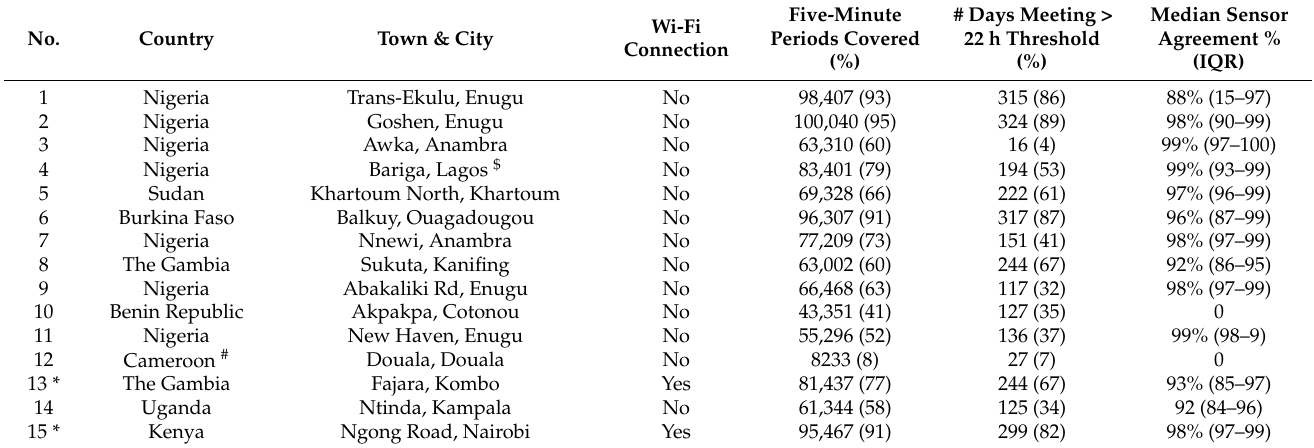
Table 1. Data coverage by location for the Measuring Air Pollution for Advocacy in Africa